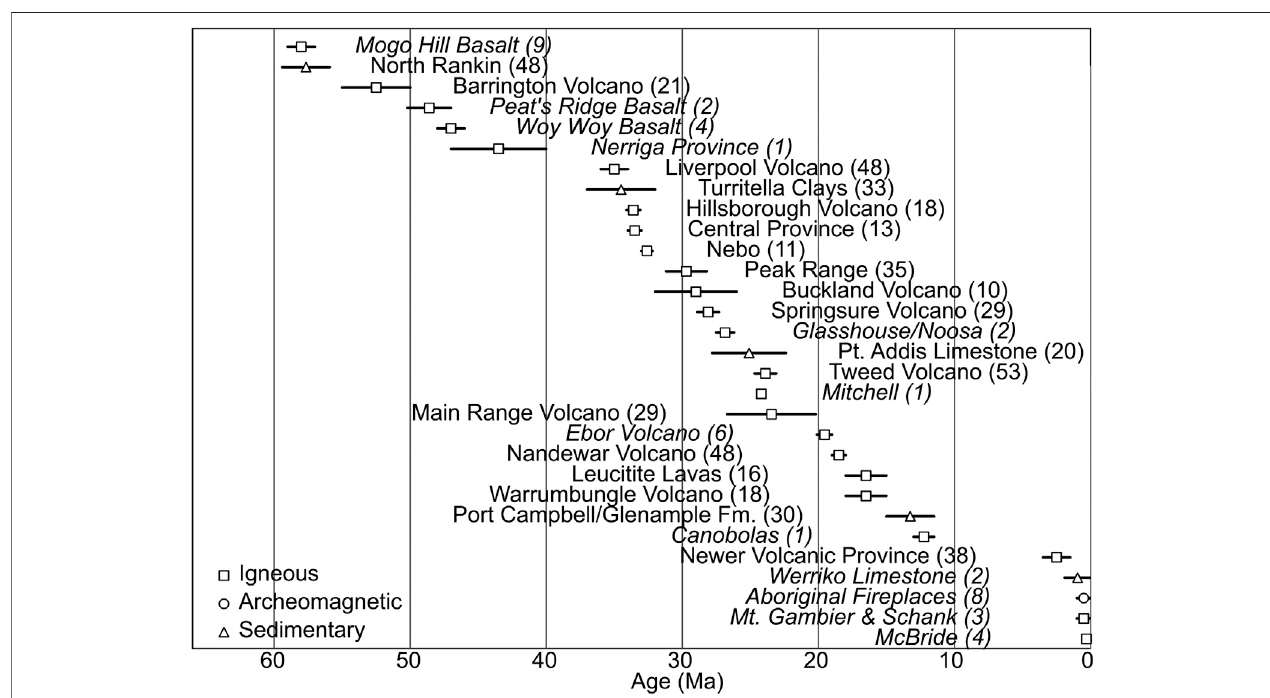
FIGURE 2 | Magnetization age bounds for Australian Cenozoic paleomagnetic data. Number of sites indicated in parenthesis. Studies are italicized where limited sampling indicate that secular variation has not been averaged within the region itself.